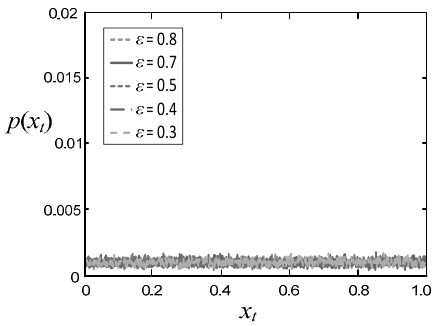
Figure 13. The simulation result of the improved compound CML, combining both the logistic map and tent map.